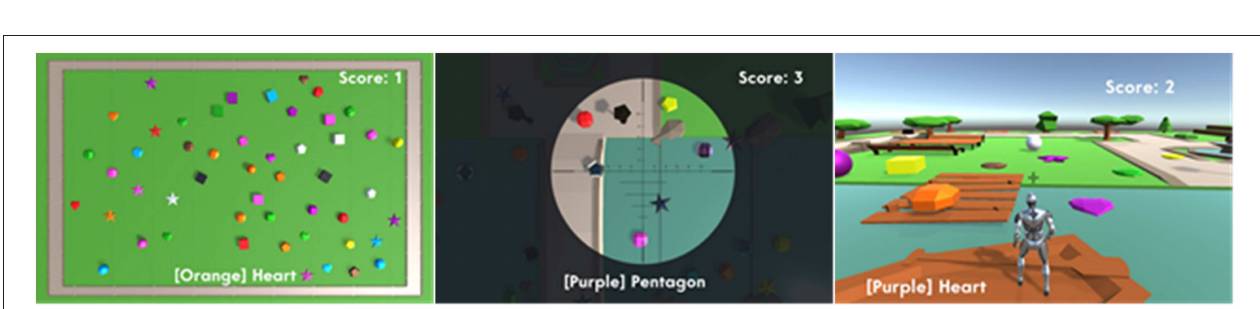
FIGURE 2 | Three games focused on the same core task (Visual Search) developed to demonstrate the application of assistance techniques. ( Left ) A hidden-object game with a top-down view. ( Middle ) A sniper game with a first-person view. ( Right ) A simple adventure game with a third-person view.